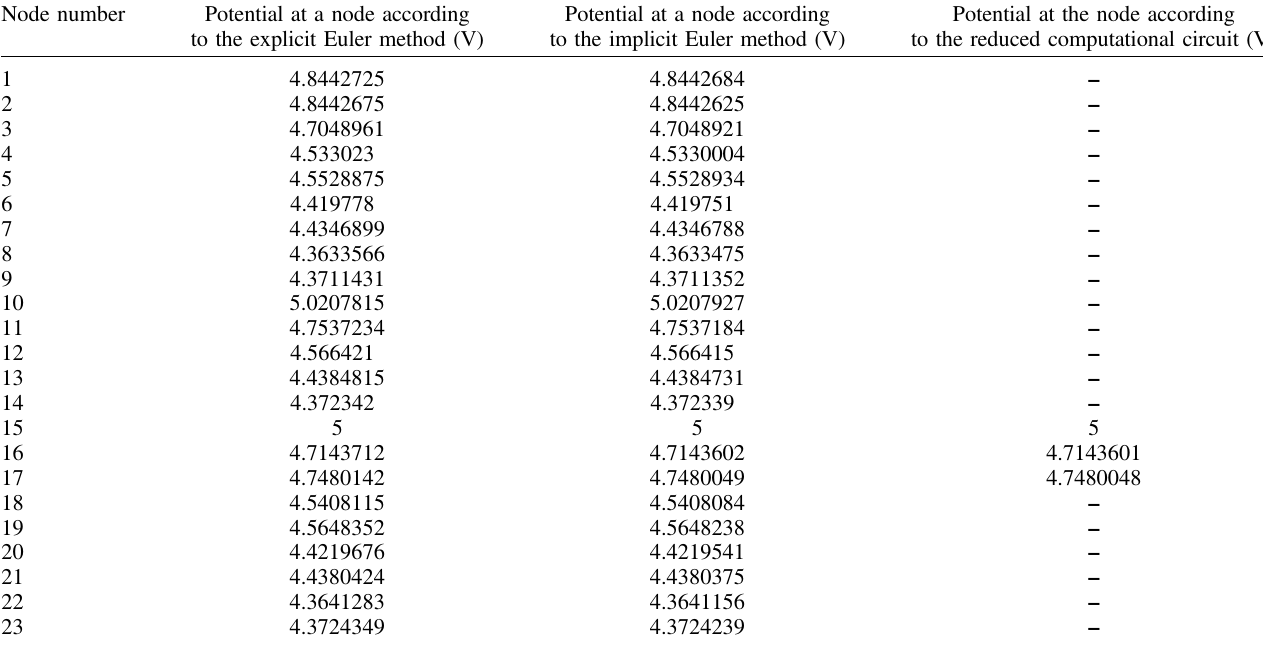
Table 4. Calculation with h = 0.001 s and number of steps = 1000, moment of time = 400 ns. Node number Potential at a node according to the explicit Euler method